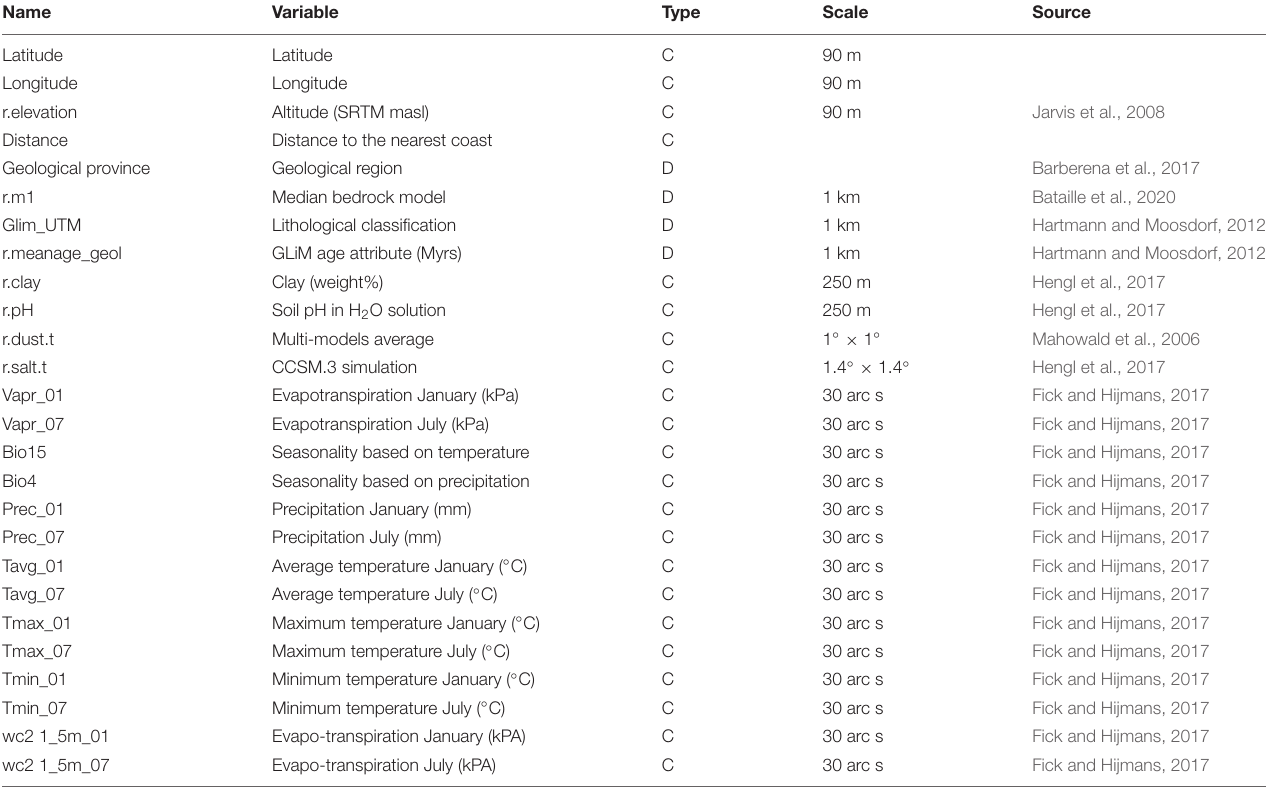
TABLE 1 | List of locational, geological, and bioclimatic variables used in the